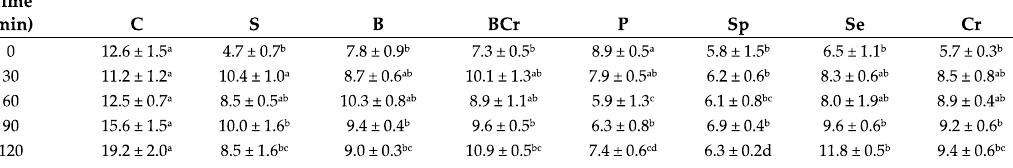
Figure 1. Serum Homocysteine (Hcy) concentration in healthy rats fed different types of dietary protein: ( A ) Fasting serum Hcy concentration and after 30, 60, 90 and 120 min of feeding casein (C), soy protein (S), black bean (B), black bean + corn (BCr), pea (P), spirulina (SP), sesame (Se) or corn (Cr); and ( B ) values are means ± SEM, n = 5. Different letter superscript indicates significant differences among rows, p < 0.05, a > b > c.